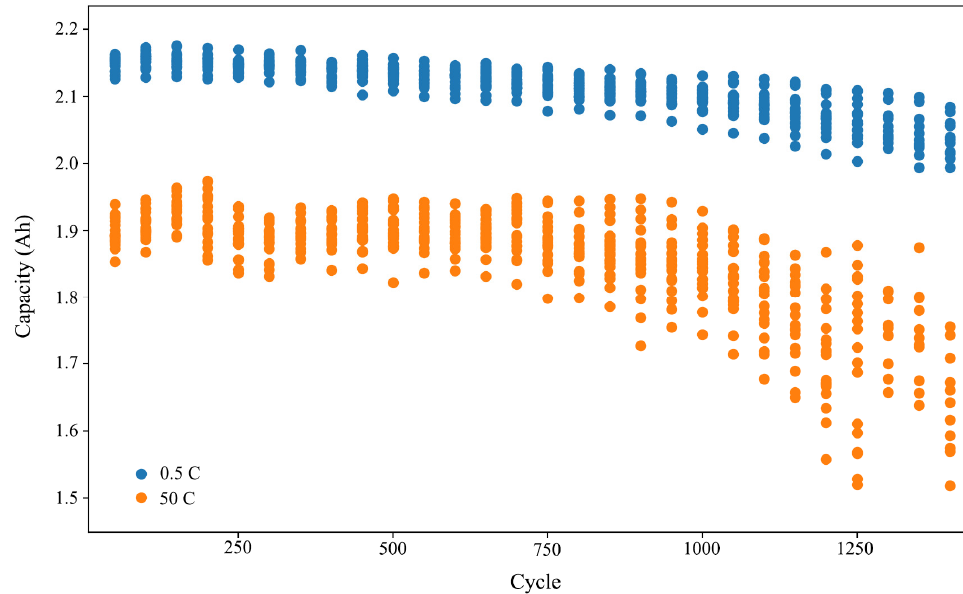
Figure 3. The capacity at 0.5 C and 50 C of all cells during aging